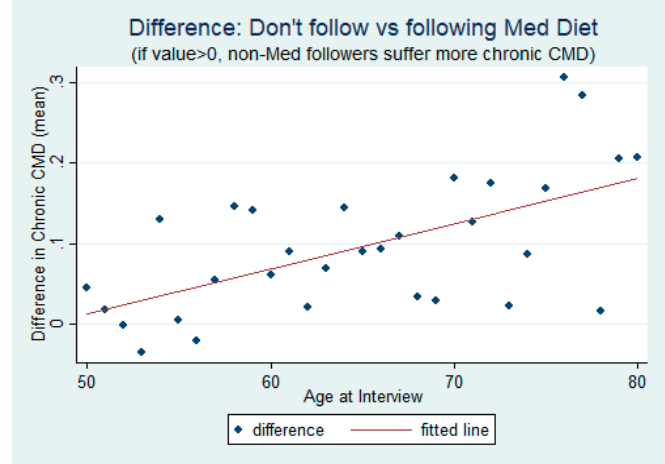
Figure 2. The difference in incidence of chronic CMDs between those following and not following the Mediterranean diet.